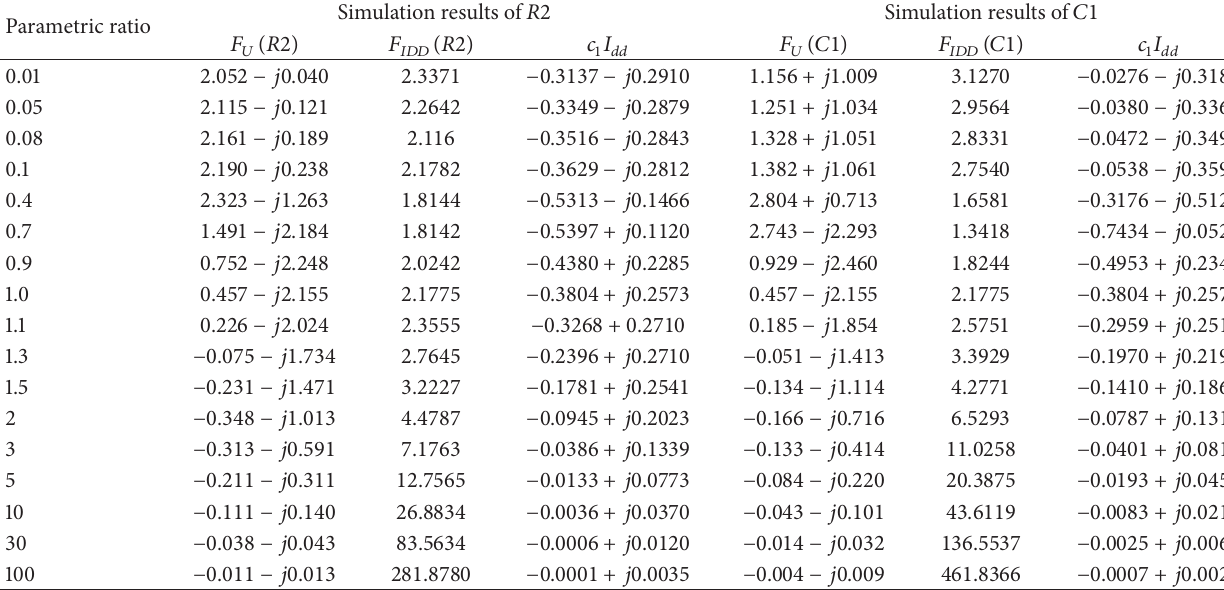
Table 3: Simulation results for 𝑅2 and 𝐶1 in 3D